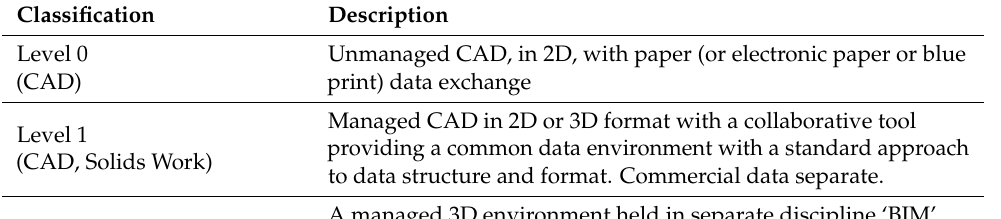
Table 1. Level of BIM